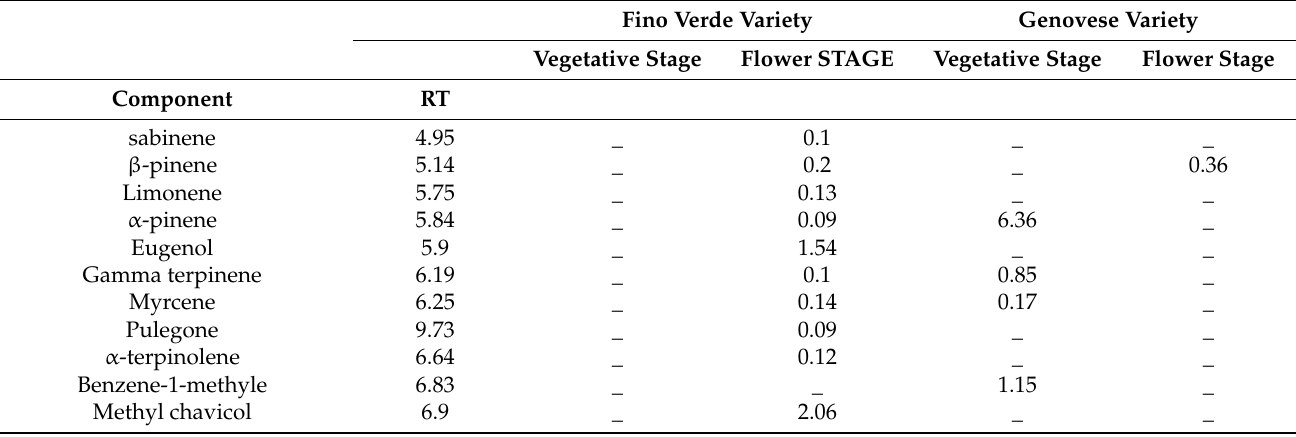
Table 1. Phenological stage effect on yields of essential oil of two O. basilicum